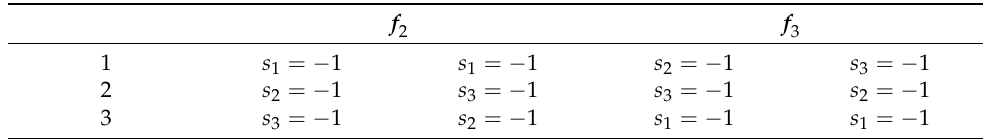
Table 7. Alternative signatures for f 2 and f 3 faults containing the values of diagnostic signals and the sequence of